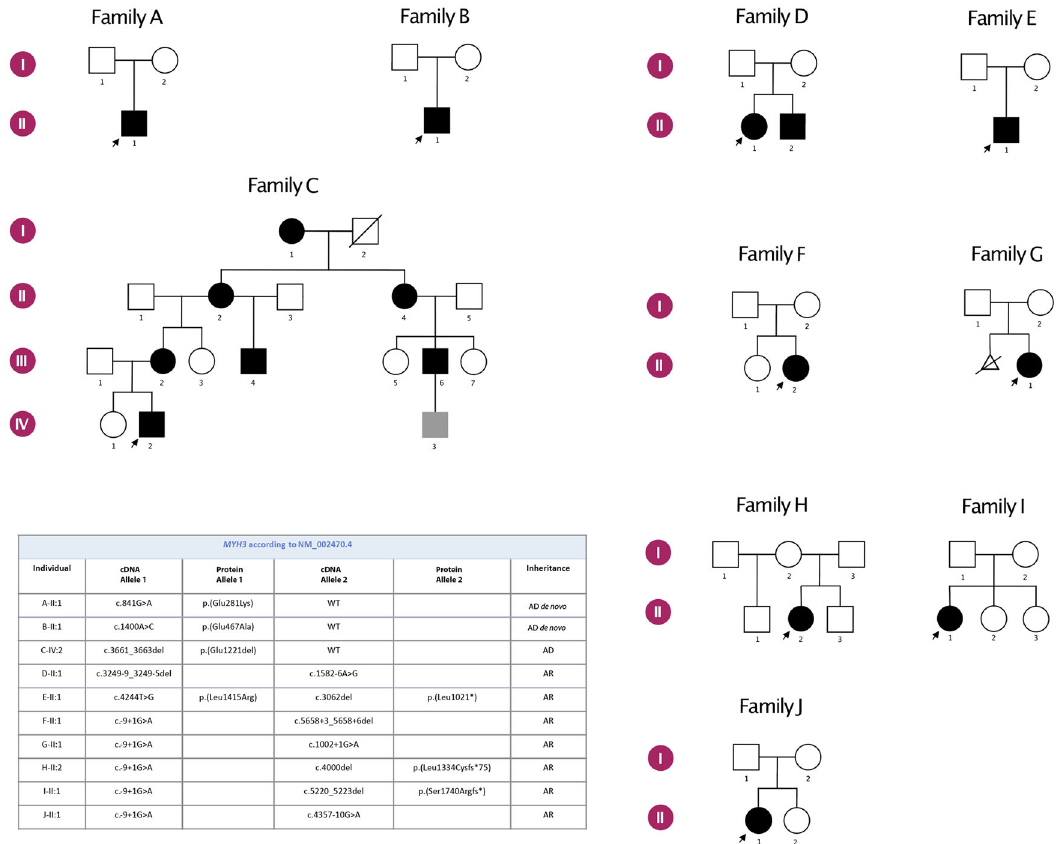
Fig. 1 Pedigrees of the participating families and the pathogenic MYH3 variants detected in the study. In family A, B and C the affected individuals have dominant MYH3 -associated skeletal fusion syndrome, in families D, E, F, G, H, I and J the affected individuals have recessive MYH3 -associated skeletal fusion syndrome. The pathogenic variants are summarized in the table below the